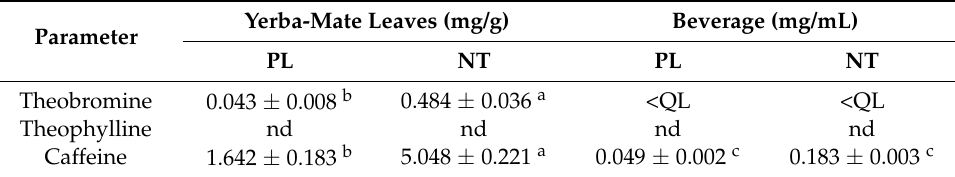
Table 3. Methylxanthines for yerba-mate and